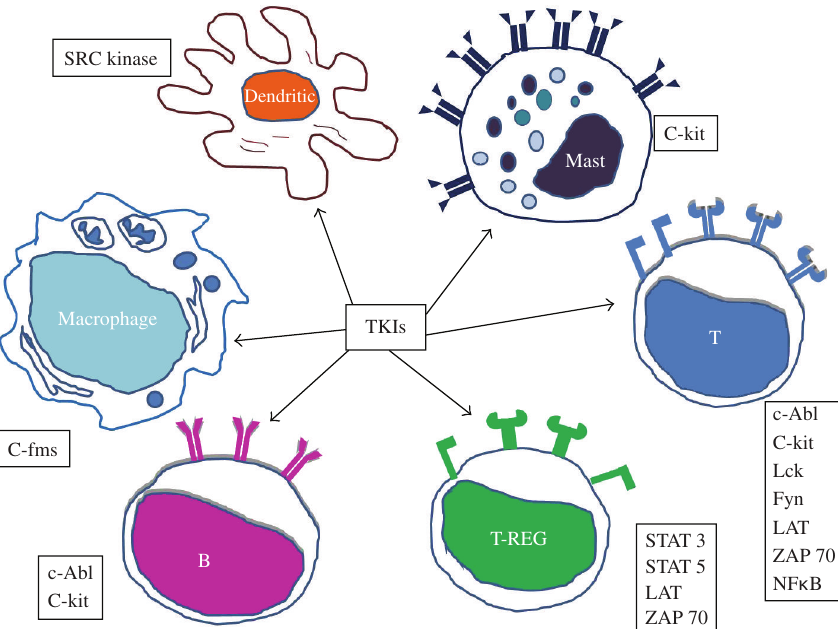
FIGURE 1: TKIs interact with several immune cells ∗ by direct or indirect link to the indicated molecules. ∗ Mast: mast cell; T: T lymphocyte; T-Reg: T regulatory lymphocyte; B: B lymphocyte; Dendritic: Dendritic cell.